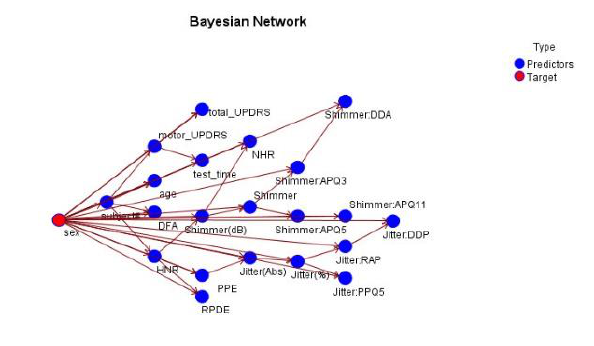
Figure 5. Generated model by Bayesian network for